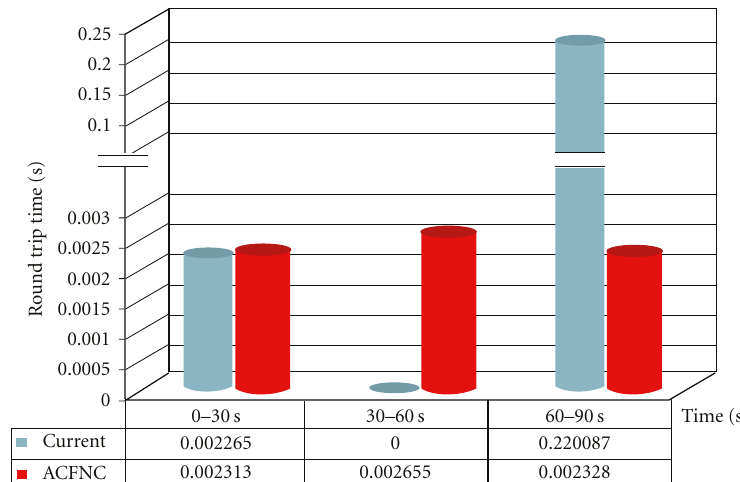
Figure 8: RTT comparison under